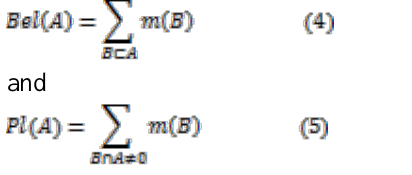
Figure 4. Location map of the study area